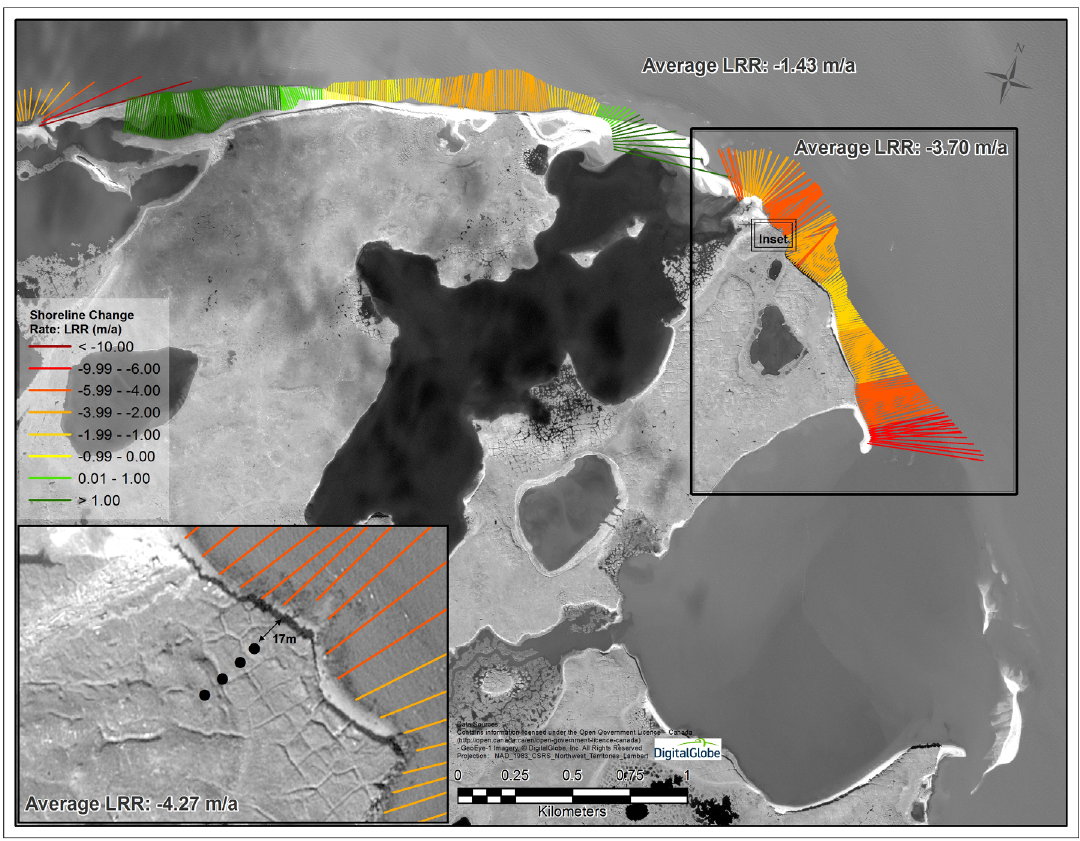
Fig. 7: Linear Regression Rate (LRR) shoreline change calculations for Toker Point, east Toker Point, and in proximity to the monitoring stakes.